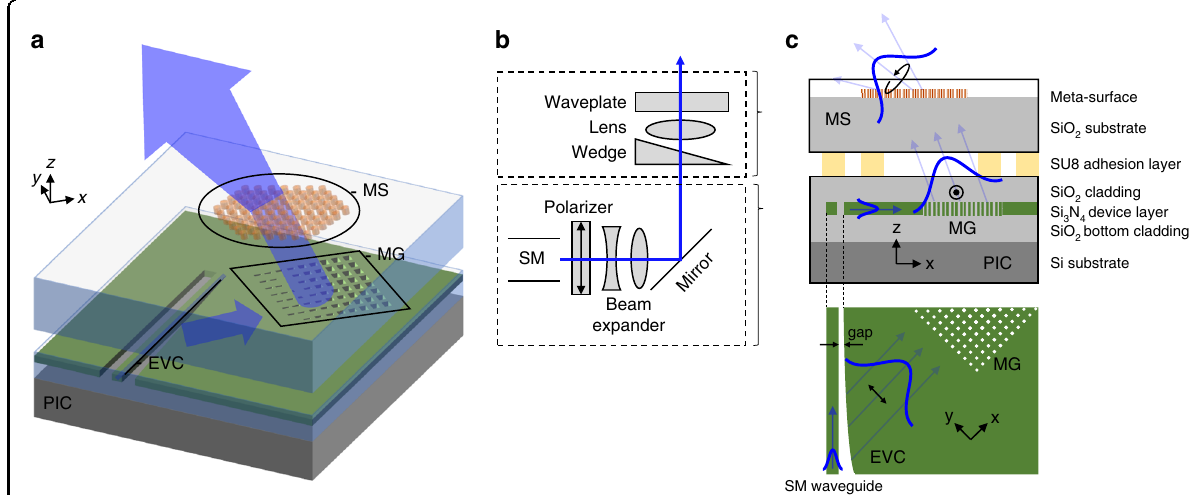
Fig. 2 Integrated photonic emitters. a Three-stage design for the beam emitter consisting of an evanescent coupler (EVC), meta-grating (MG), and metasurface (MS) with each component contributing to beam shaping and polarization control. b The analogous free-space optics that the PIC and MS devices replace. c The EVC and MG are fabricated in a single silicon nitride device layer and function together as a polarizing beam splitter and a beam expander. Both top-down (bottom) and side (middle) views of the PIC devices are shown. The MS is fabricated on fused silica (top) and can be designed to function as a combination of an optical wedge, lens and waveplate. Polarization is denoted in